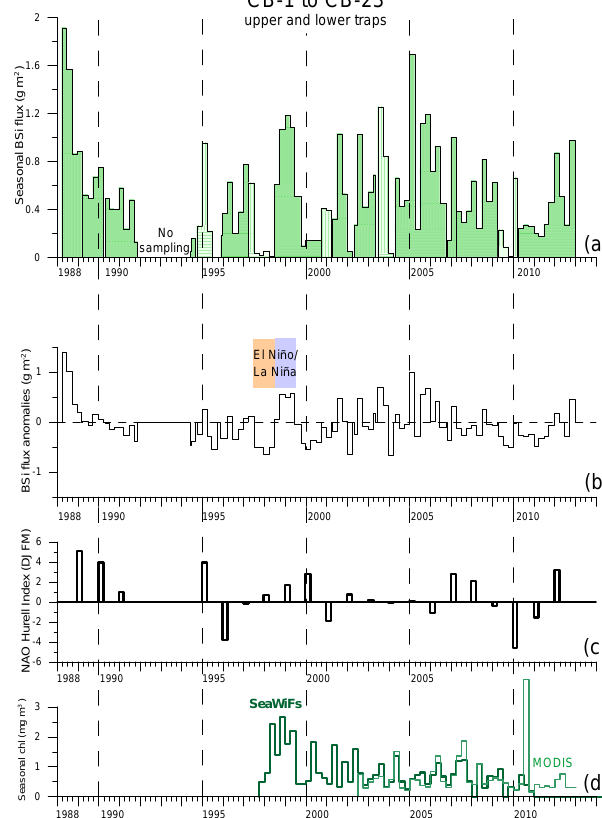
Figure 6. (a) Seasonal flux of biogenic silica (BSi, green) with gaps filled from the upper trap data (light green bars). Deviations of the long-term seasonal means (anomalies, b ). (c) The NAO Hurrell index (DJFM). (d) Seasonal chlorophyll concentration both from the MODIS (light green) and the SeaWiFS (dark green) sensors at 9 km resolution. Note that high chlorophyll biomass generally occurs in spring but sometimes in summer/autumn as well (e.g. in 1998, 2007). SeaWiFS chlorophyll reveals a decreasing trend from 1997–2010, not mimicked in any flux data. The strong ENSO cy- cle 1997–1999 with a warm El Niño and a cold La Niña phase is